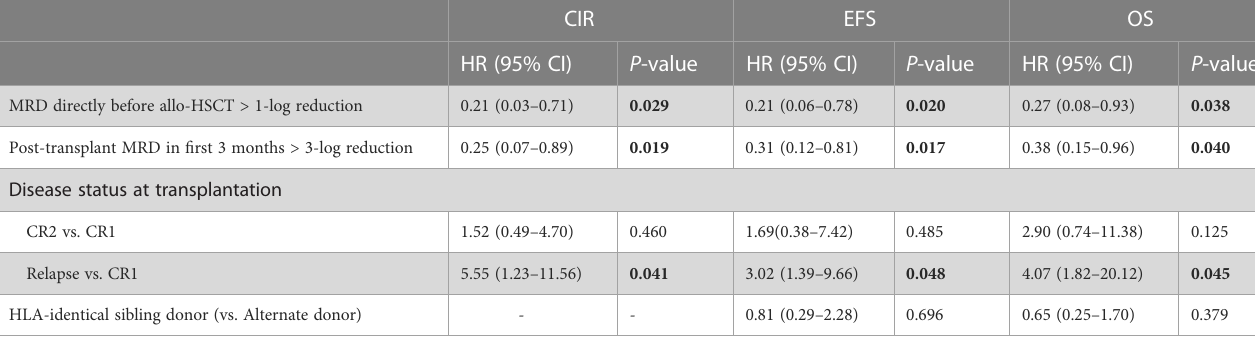
TABLE 3 Multivariate analysis of post-transplant CIR, EFS, and OS in t(8;21) AML patients undergoing